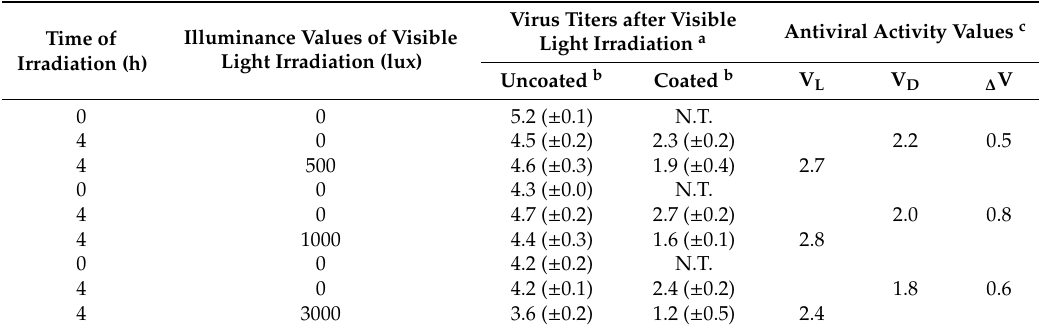
Table 1. Inactivation of bovine coronavirus on photocatalytic uncoated or coated films after 4 h with or without visible light irradiation at di ff erent illuminance